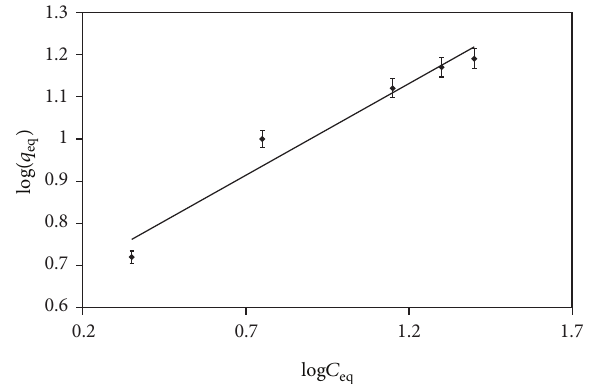
Figure 8: Freundlich biosorption isotherm for lead at 0.1g in 30mL of biosorbent concentration and solution pH of